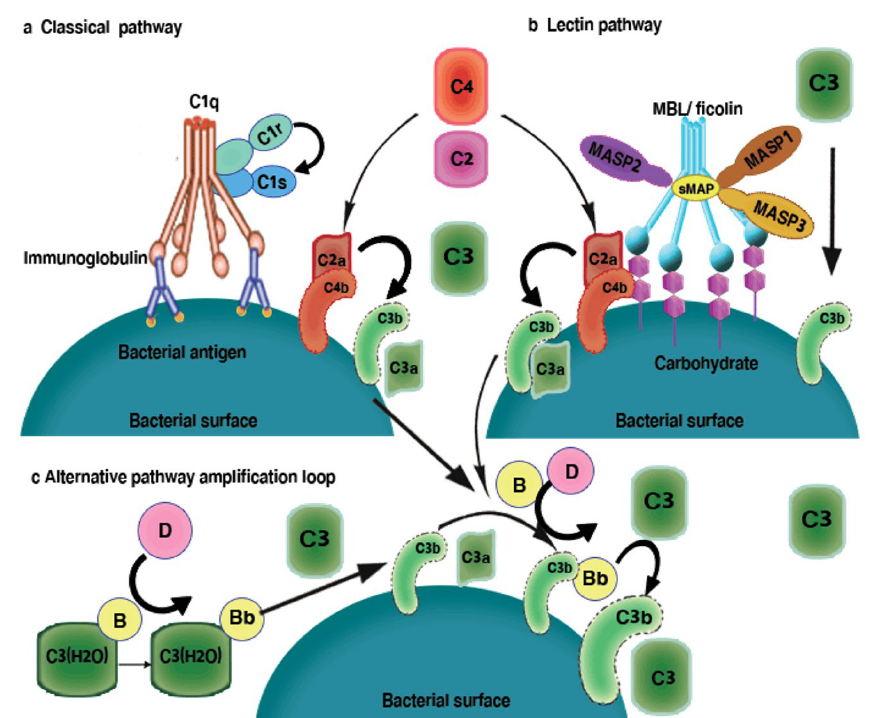
Fig. 1. Complement activation pathway: (A) The classical pathway is initiated by the binding of the C1 complex to antibodies that are bound to antigens on the surface of bacteria. The C1 complex consists of C1q and tow molecules each of C1r and C1s. The binding of the recognition subcomponent C1q to the Fc portion of immunoglobulins